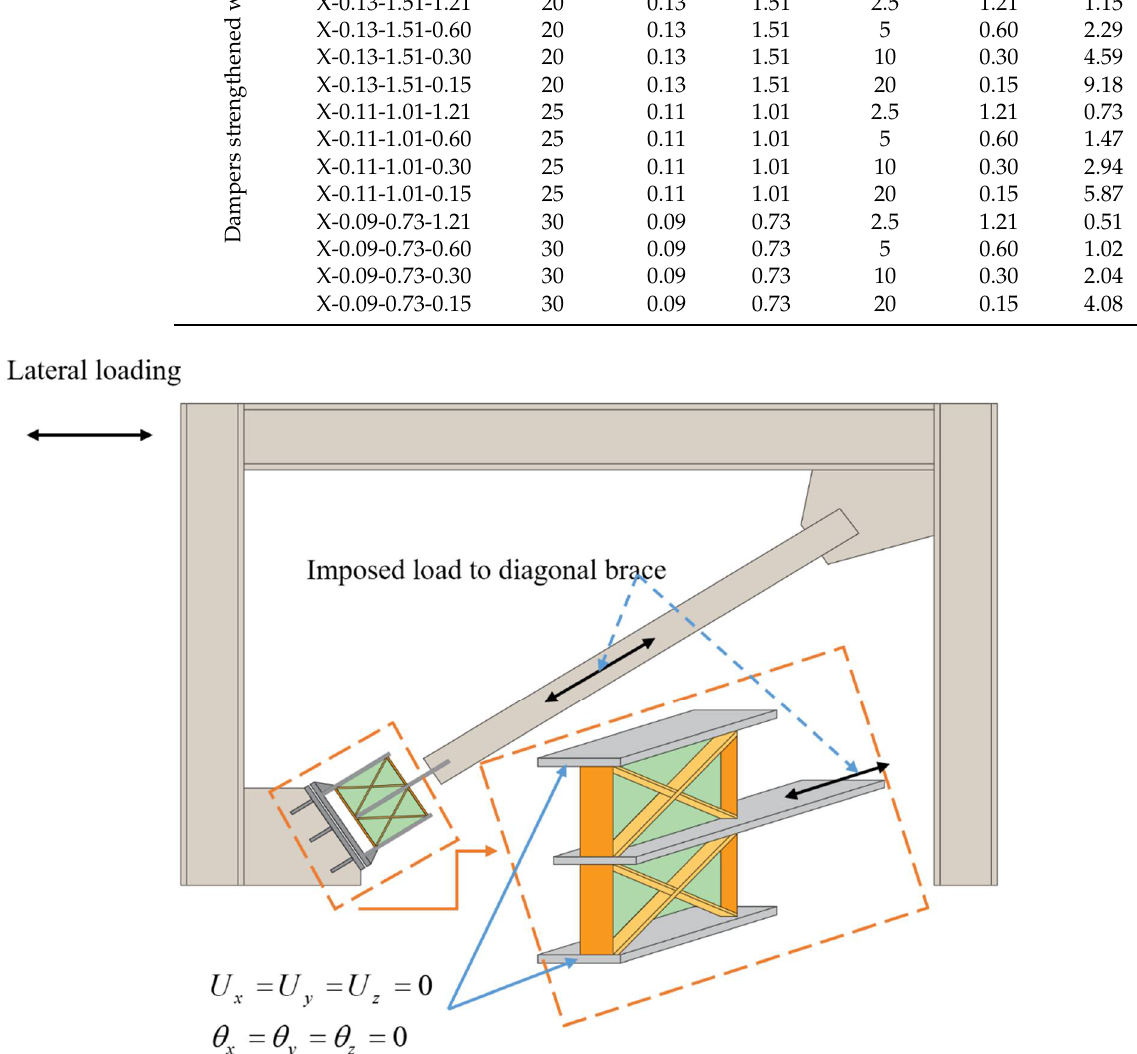
Figure 3. Boundary conditions of simplified damper. Additionally, A36 steel with a yield strength of 235 MPa, Young’s modulus of 200 GPa, and Poisson’s ratio of 0.3 were employed for all the